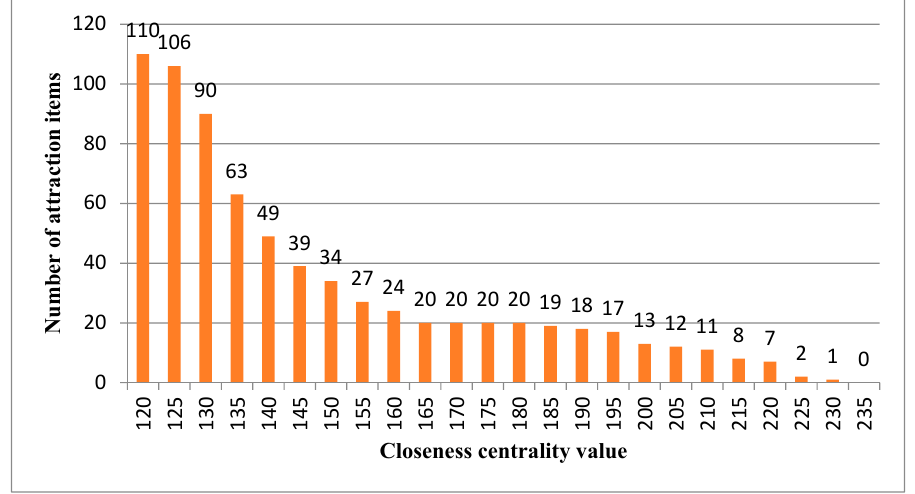
Figure 10. Relationship between closeness centrality and α value in TBN. Table 8. Number of attraction and opportunity items using closeness centrality.